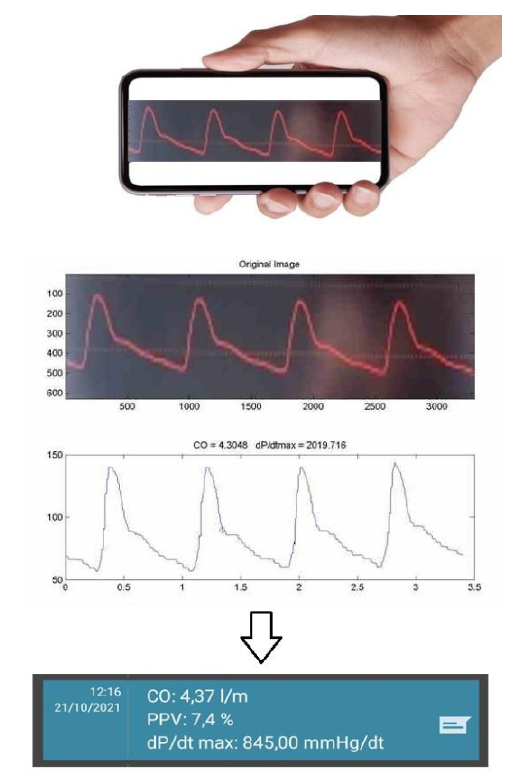
Figure 1. The method of measuring cardiac output by